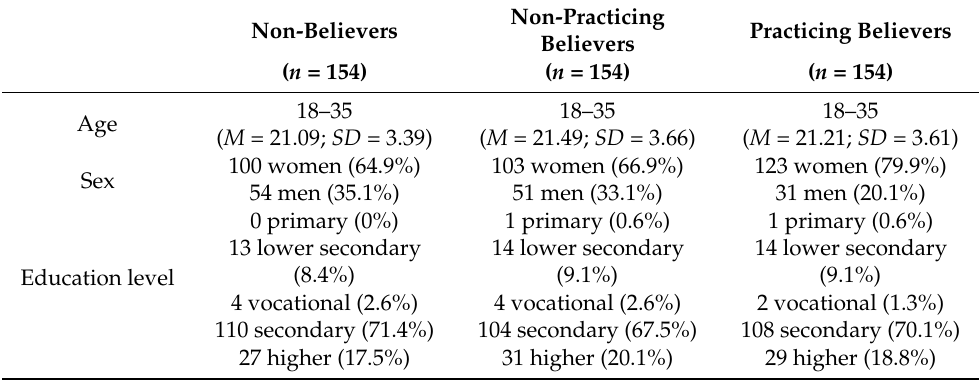
Table 1. Demographic characteristics of the members of the subgroups selected in the study ( N = 462).